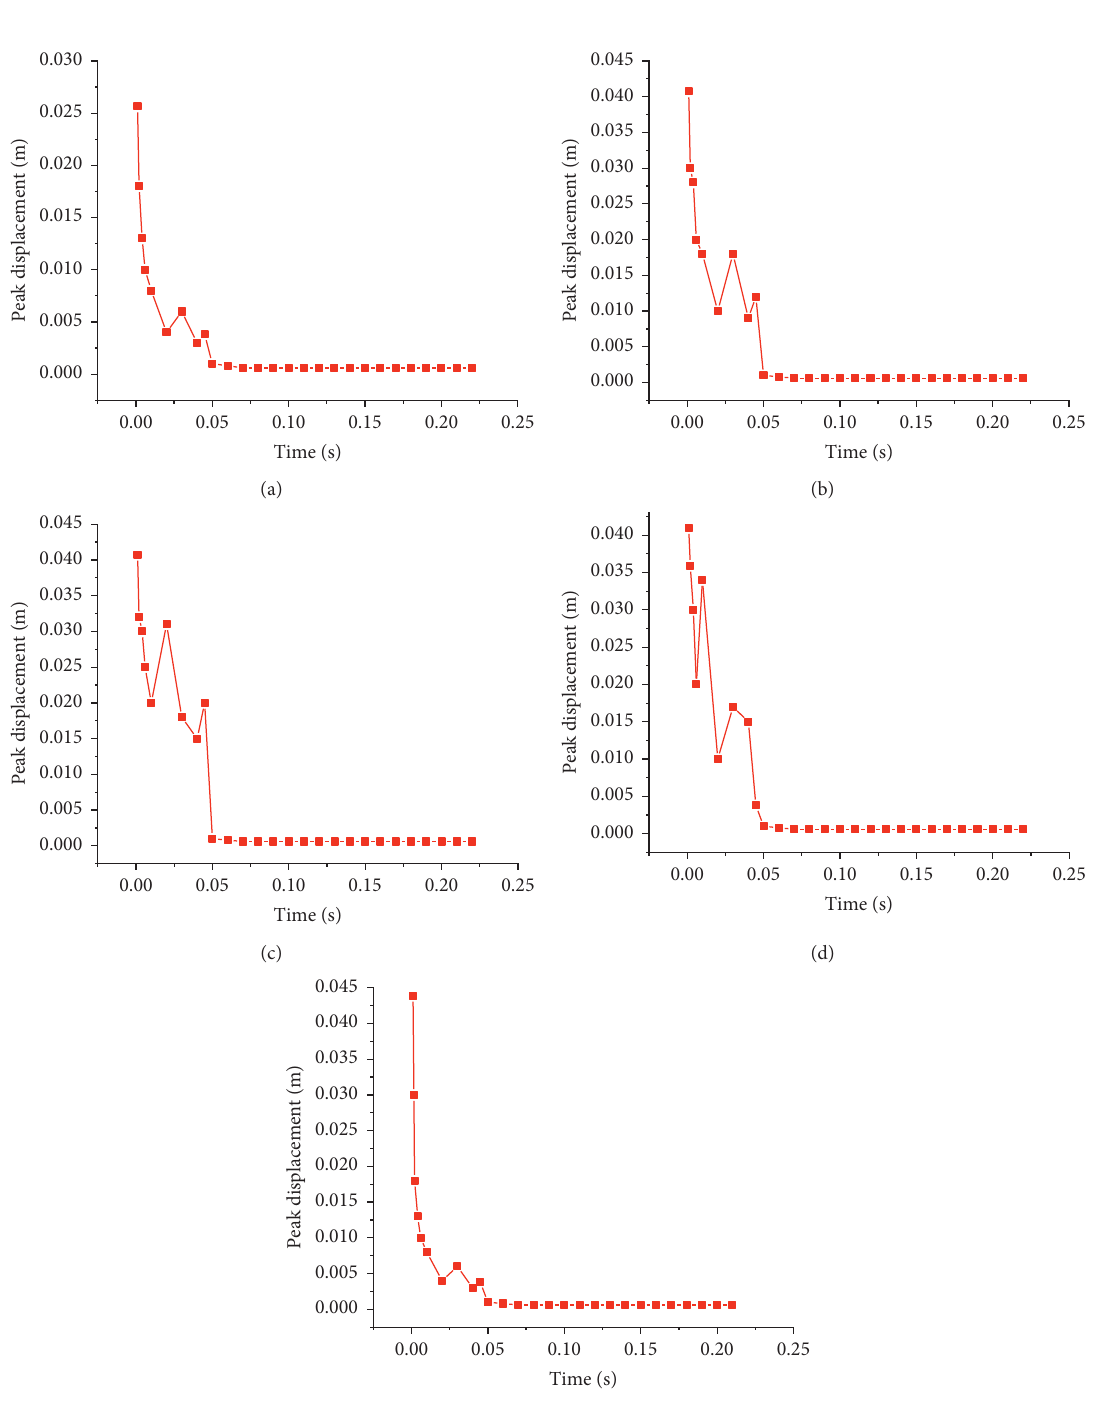
Figure 5: Displacement change of the arch bottom measuring point at profile 1-1. (a) First blast. (b) Second blast. (c) Third blast. (d) Fourth blast. (e) Fifth